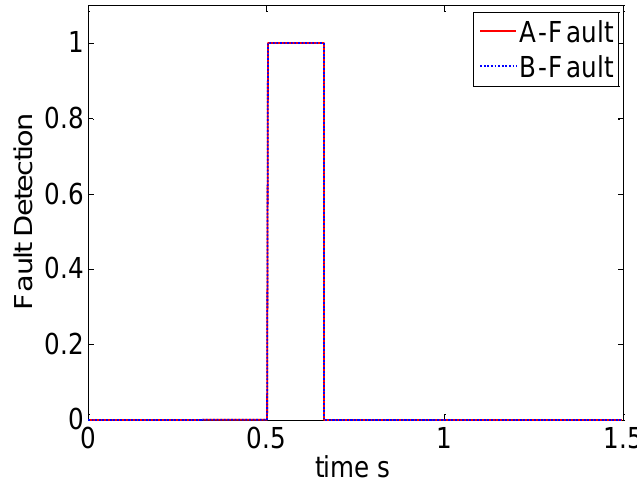
Figure 9. Fault detection signal for scenario A and B.